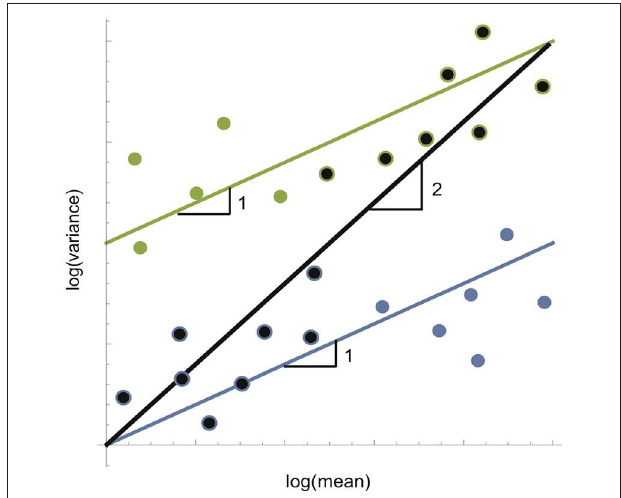
FIGURE 1 | Conceptual figure of how lower variance of large groups or higher variance of small groups can reduce Taylor’s law slopes from the null of 2 to 1. Color of points match regression lines they belong to. Bicolor points belong to two regression